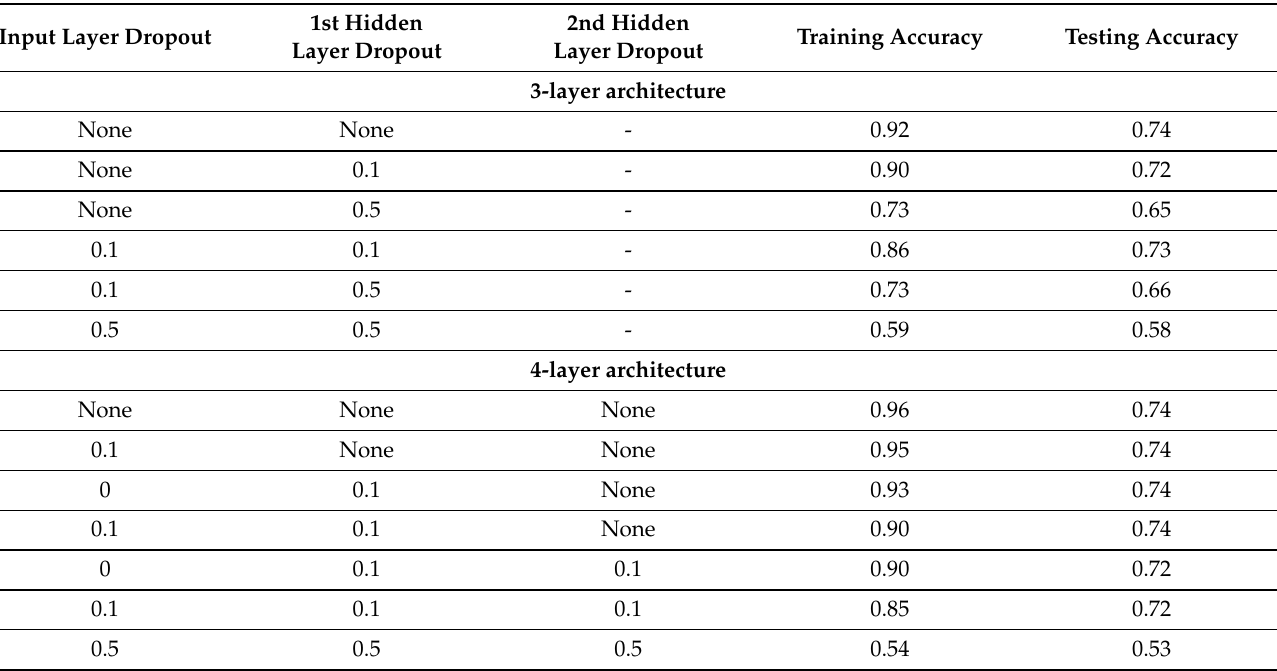
Table 3. Training and testing accuracies for the 3- and 4-layer MLP architecture with dropout layers (1 and 2 hidden layers,